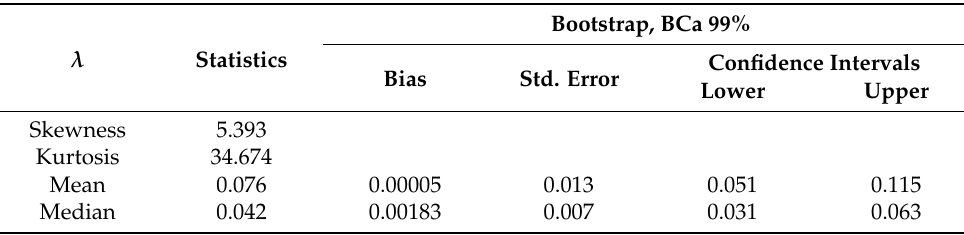
Table 3. Inferential statistics results of derived λ for M90 decadal dataset at α =